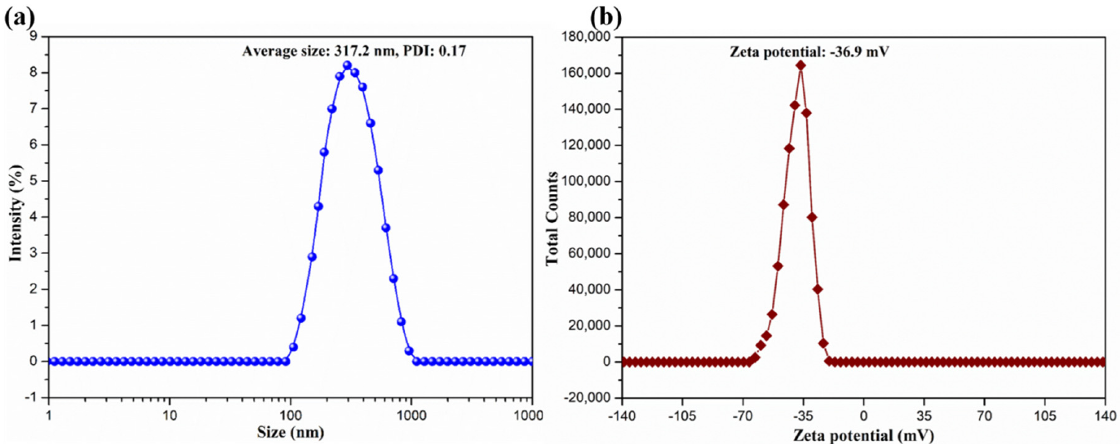
Figure 2. ( a ) Size distribution and ( b ) zeta potential distribution of BCNs.